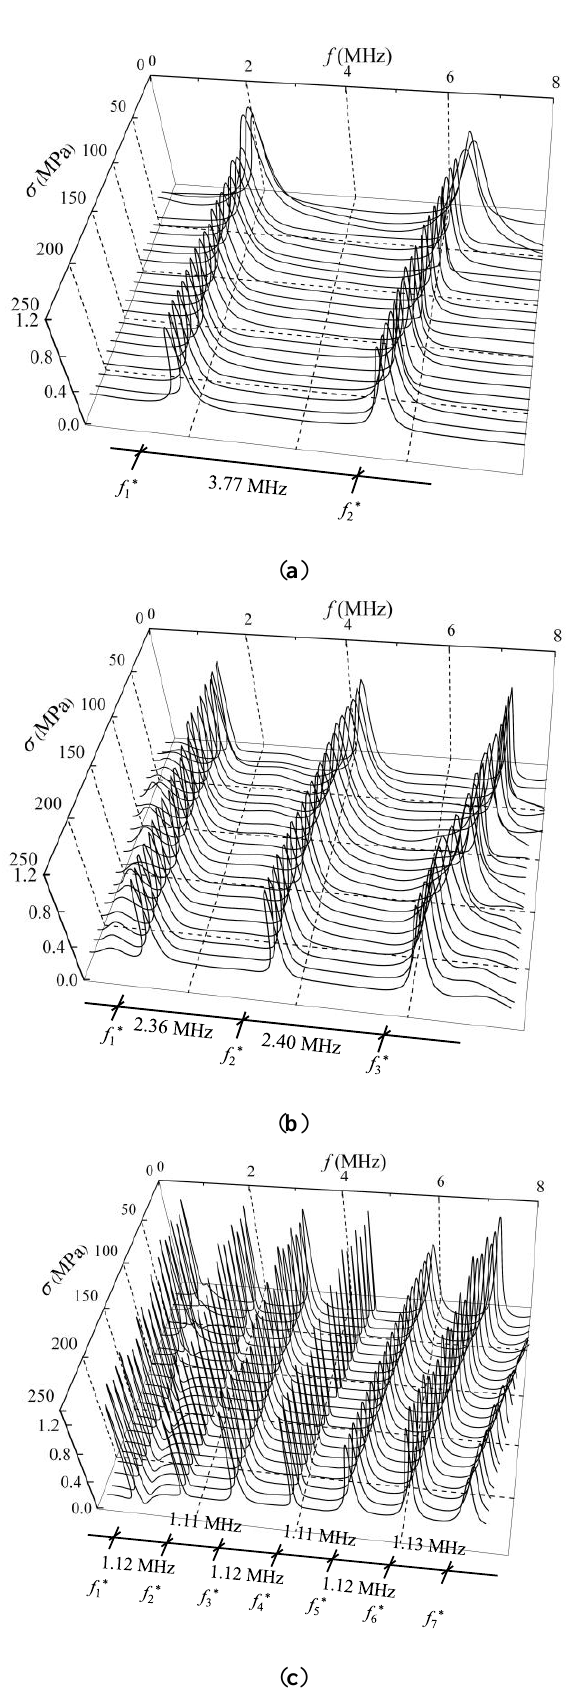
Figure 9. The normalized derivation of the phase difference curves under different compressive stress states in ( a ) sample C1; ( b ) sample C2; and ( c ) sample C3.